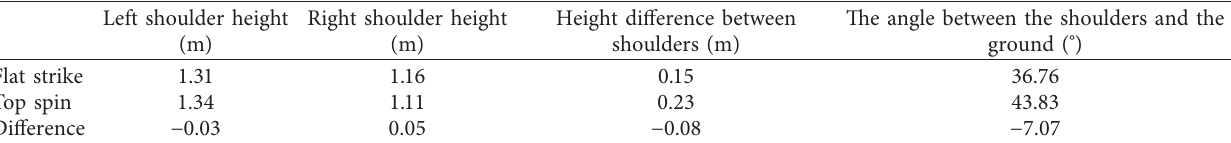
Figure 9: Comparison of the smallest angles of the knee and hip joints at the racket stage of the top spin. Table 4: Comparison of spatial characteristics at the lowest point of the shoulder joint in racket